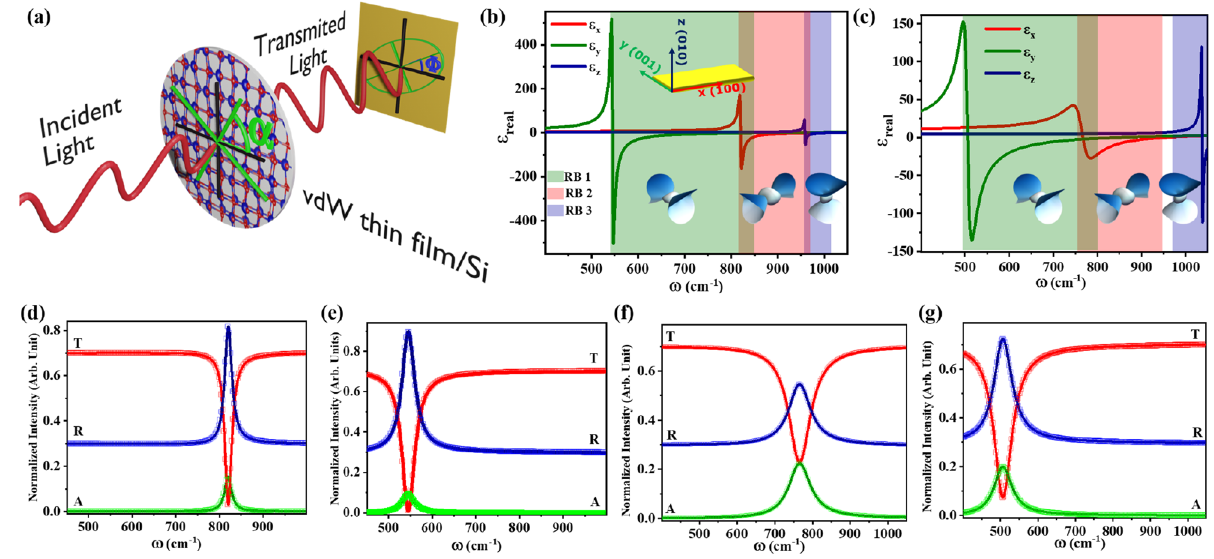
Figure 1. ( a ) Schematic illustration of geometry for vdW thin films (i.e. α - MoO 3 or α - V 2 O 5 ) on silicon substrate based polarizer and polarization rotator. ( b , c ) show real part of dielectric permittivities of α - MoO 3 and α - V 2 O 5 , respectively, along x , y and z crystallographic direction which reveal the natural biaxial hyperbolicity of α - MoO 3 and of α - V 2 O 5 vdW crystals. Spectral region colored in green, red and blue represents Reststrahlen Bands (RBs) 1, 2 and 3 respectively. (Insets show isofrequency surfaces 37 in the respective RB spectral regions.) ( d , e ) represent the optical response of 100 nm thin film of α - MoO 3 for x − and y -polarized light respectively. ( f , g ) represent the optical responses of 100 nm thin film of α - V 2 O 5 for x - and y -polarized light respectively. Scatter plots and line plots in ( d – g ) represent optical responses obtained from numerical simulations and TMM respectively. A, R and T in ( d – g ) correspond to absorbance, reflectance and transmittance